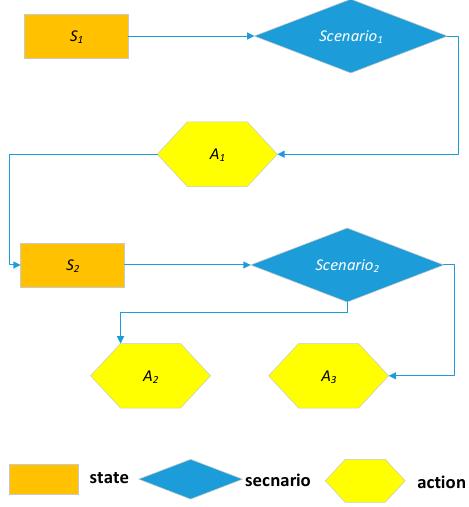
Figure 2. Scenario analysis